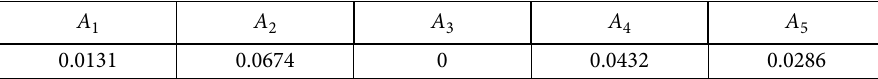
Table 15. The weighted NDA of the enhancement EDAS method based on the CPT